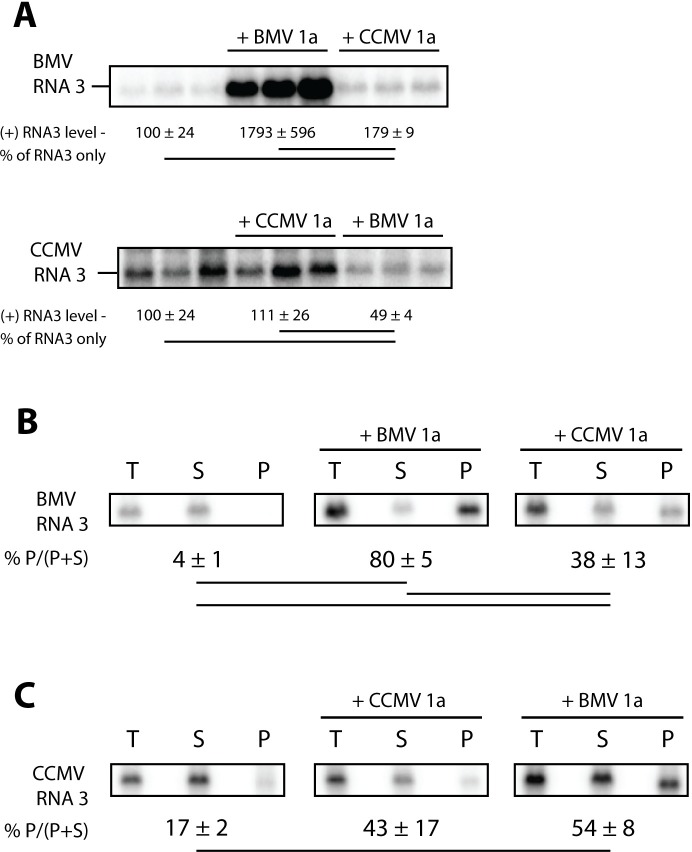
CCMV 1a is defective relative to BMV 1a in recruiting RNA templates to membranes.(A) Positive-strand BMV or CCMV RNA3 accumulation was detected by northern blotting from cells expressing RNA3 alone or with BMV or CCMV 1a as indicated. (B,C) As in (A) except yeast were lysed and centrifuged to pellet cellular membranes prior to RNA isolation. Accumulation of positive-strand RNA3 was assayed from total lysate (T), supernatant (S), and pellet (P) fractions. The relative percentage of RNA in the pellet fraction is indicated below each gel as the average and standard deviation quantified from three fractionations. A line connecting two numbers indicates a statistically significant difference (p<0.05).